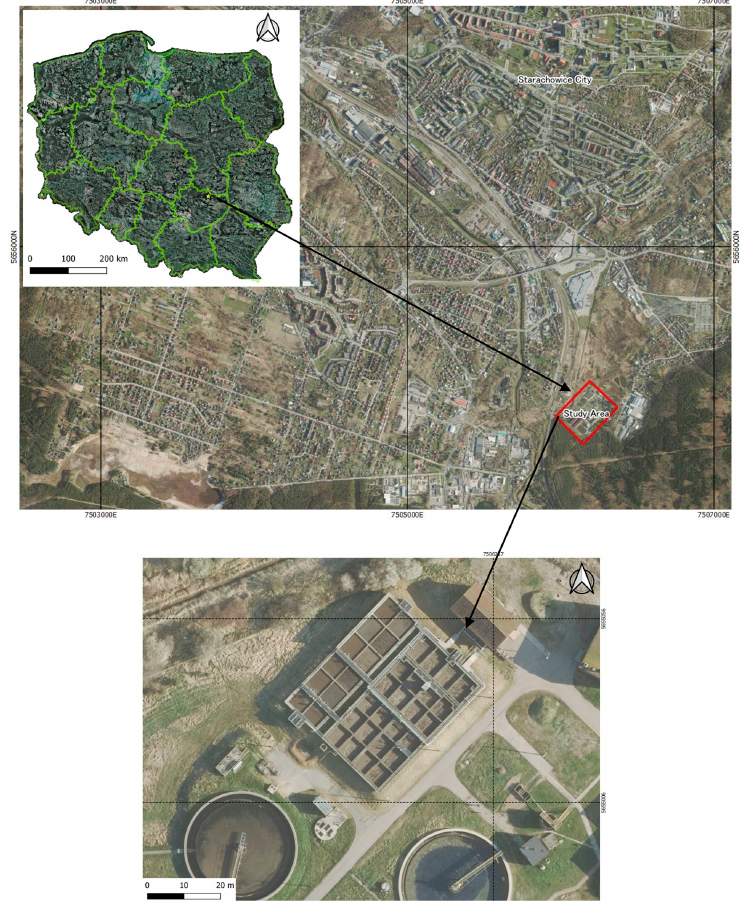
Figure 1. Location of the testing area in Starachowice (Poland).